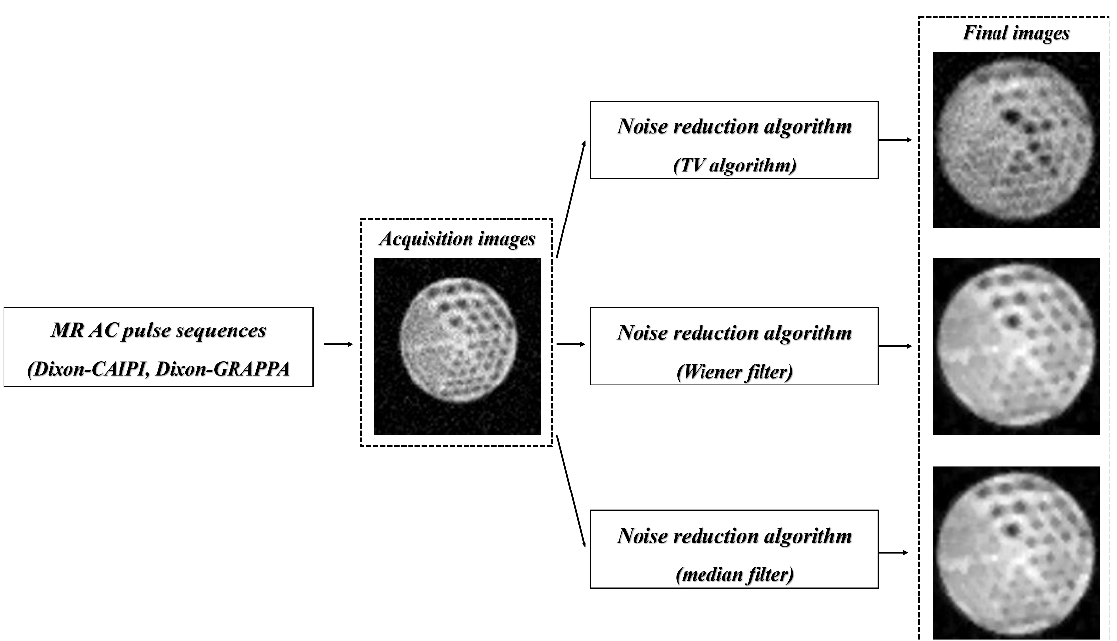
Figure 2. Flowchart for acquisition of images applied to MR Dixon-CAIPI and MR Dixon-GRAPPA AC pulse sequences to final images using the total variation (TV) algorithm, Wiener filter, and median filter for noise reduction.